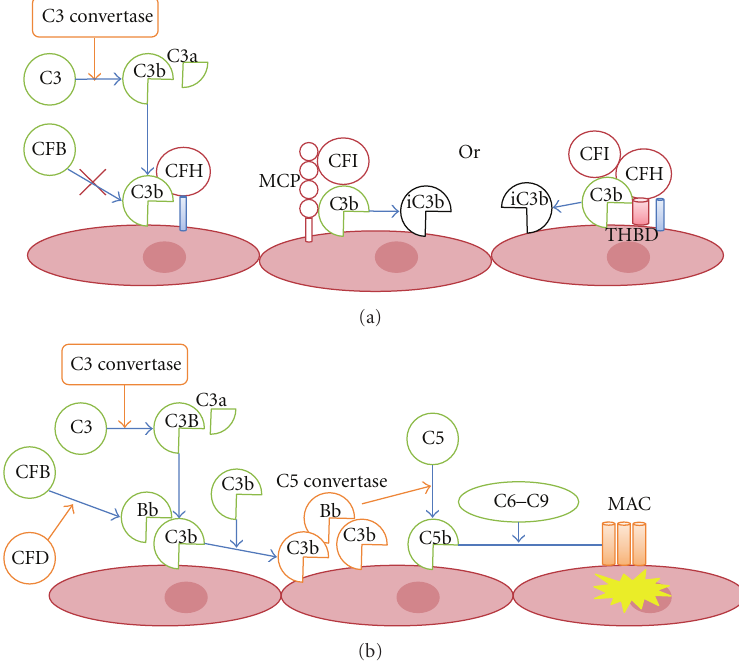
Figure 2: Regulation and dysregulation of complement activity on host cells. C3b is generated by the classical, lectin, or alternative pathways. (a) To protect normal host cells, C3b is inactivated by membrane regulators, such as factor H (CFH) and membrane cofactor protein (MCP). Factor I (CFI) cleaves C3b into iC3b and other C3 degradation products with the activity of cofactor regulators. (b) If genetic and/or environmental risk factors reduce the e ffi ciency of membrane complement regulators, C3 convertase (C3bBb) can accumulate on cell surfaces, creating a C3b amplification loop. Formation of C5 convertase (C3bBbC3b) triggers C5 cleavage into C5b, which interacts with C6, C7, C8, and C9 to generate membrane attack complex (MAC) leading to cell